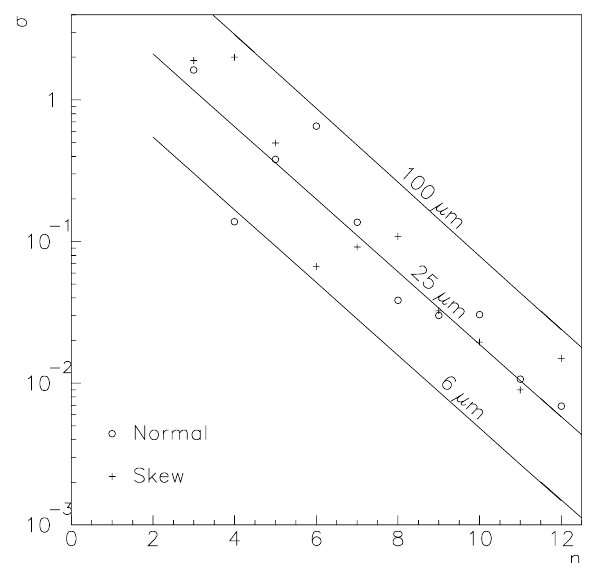
FIG. 9. rms of the multipole averages for the first three LHC quadrupole prototypes (markers) and scaling law for different amplitudes of random displacements d (solid